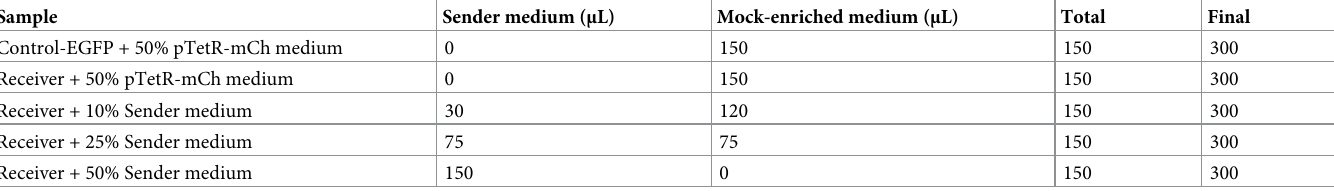
Table 1. Preparation of receiver induction